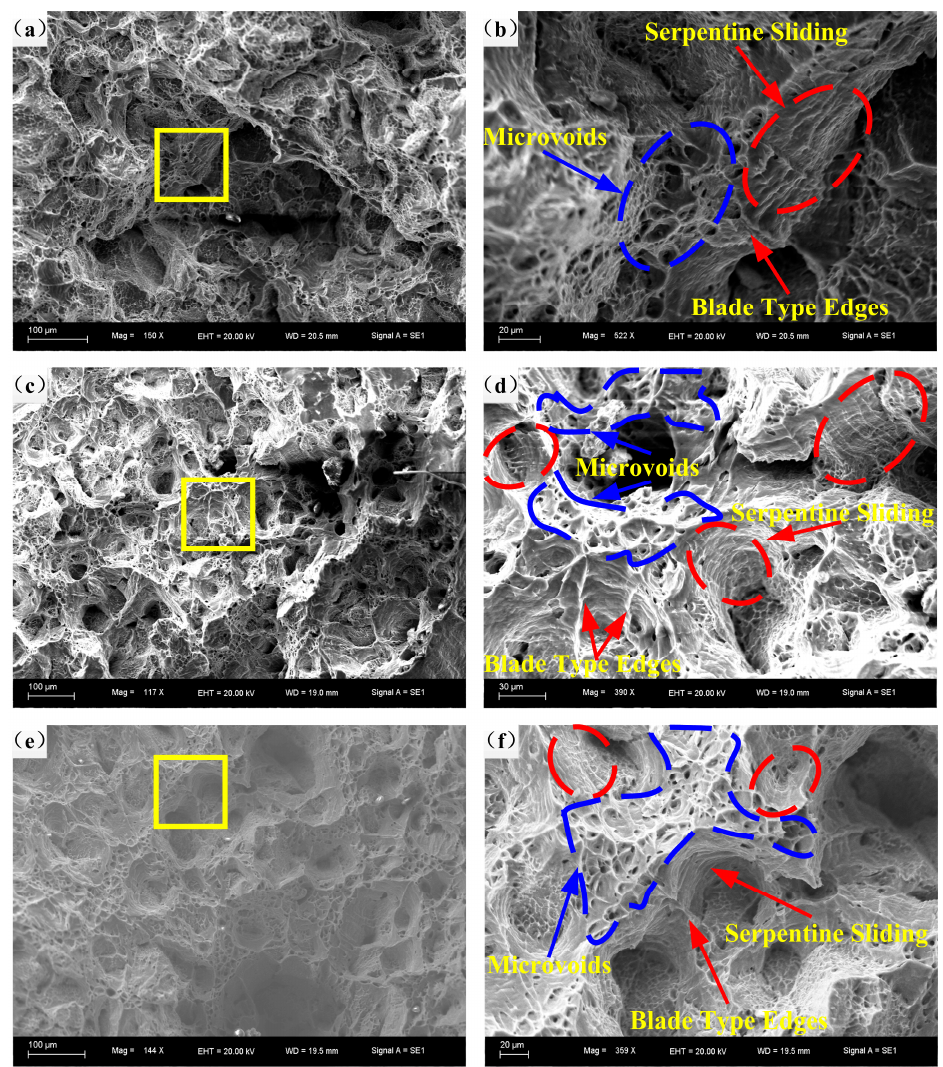
Figure 12. Fracture morphologies at 300 °C and at strain rates of: ( a , b ) 10 − 3 s − 1 ; ( c , d ) 10 − 2 s − 1 ; ( e , f ) 10 − 1 s − 1 .